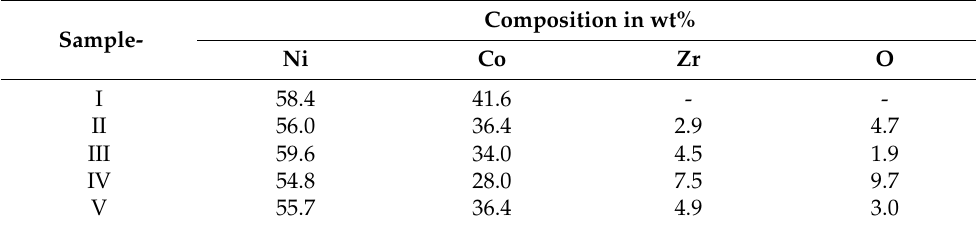
Table 3. Mass fraction of elements in alloy coated samples prepared under different conditions. Sample-